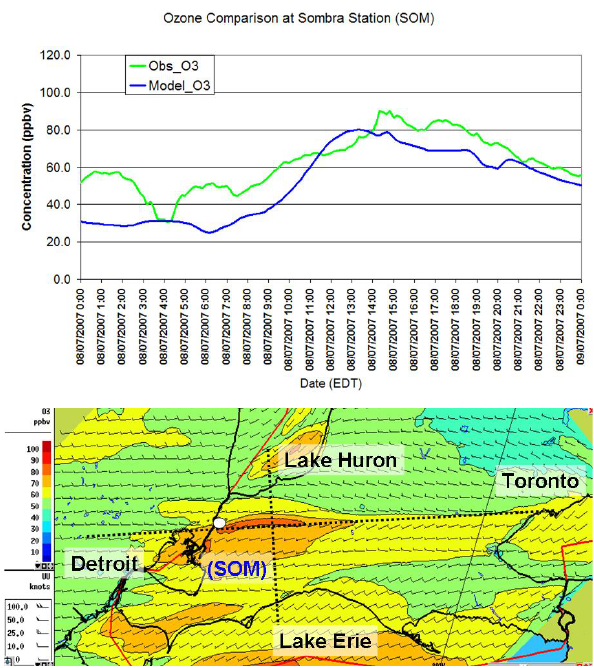
Fig. 13. Model-predicted ozone mass tracking fields for 8 July, 17:00 UT (01:00p.m. local time), Detroit to Toronto cross-section.